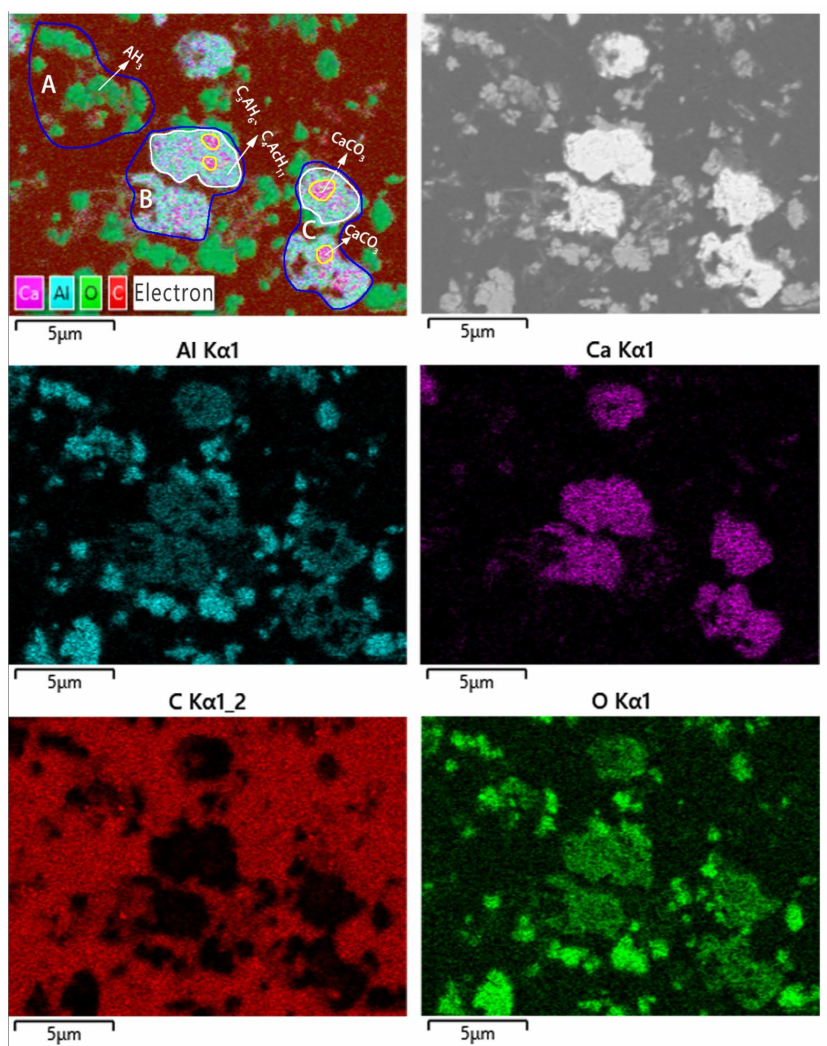
Figure 6. SEM image and EDS mapping of calcite-type precipitated calcium carbonate